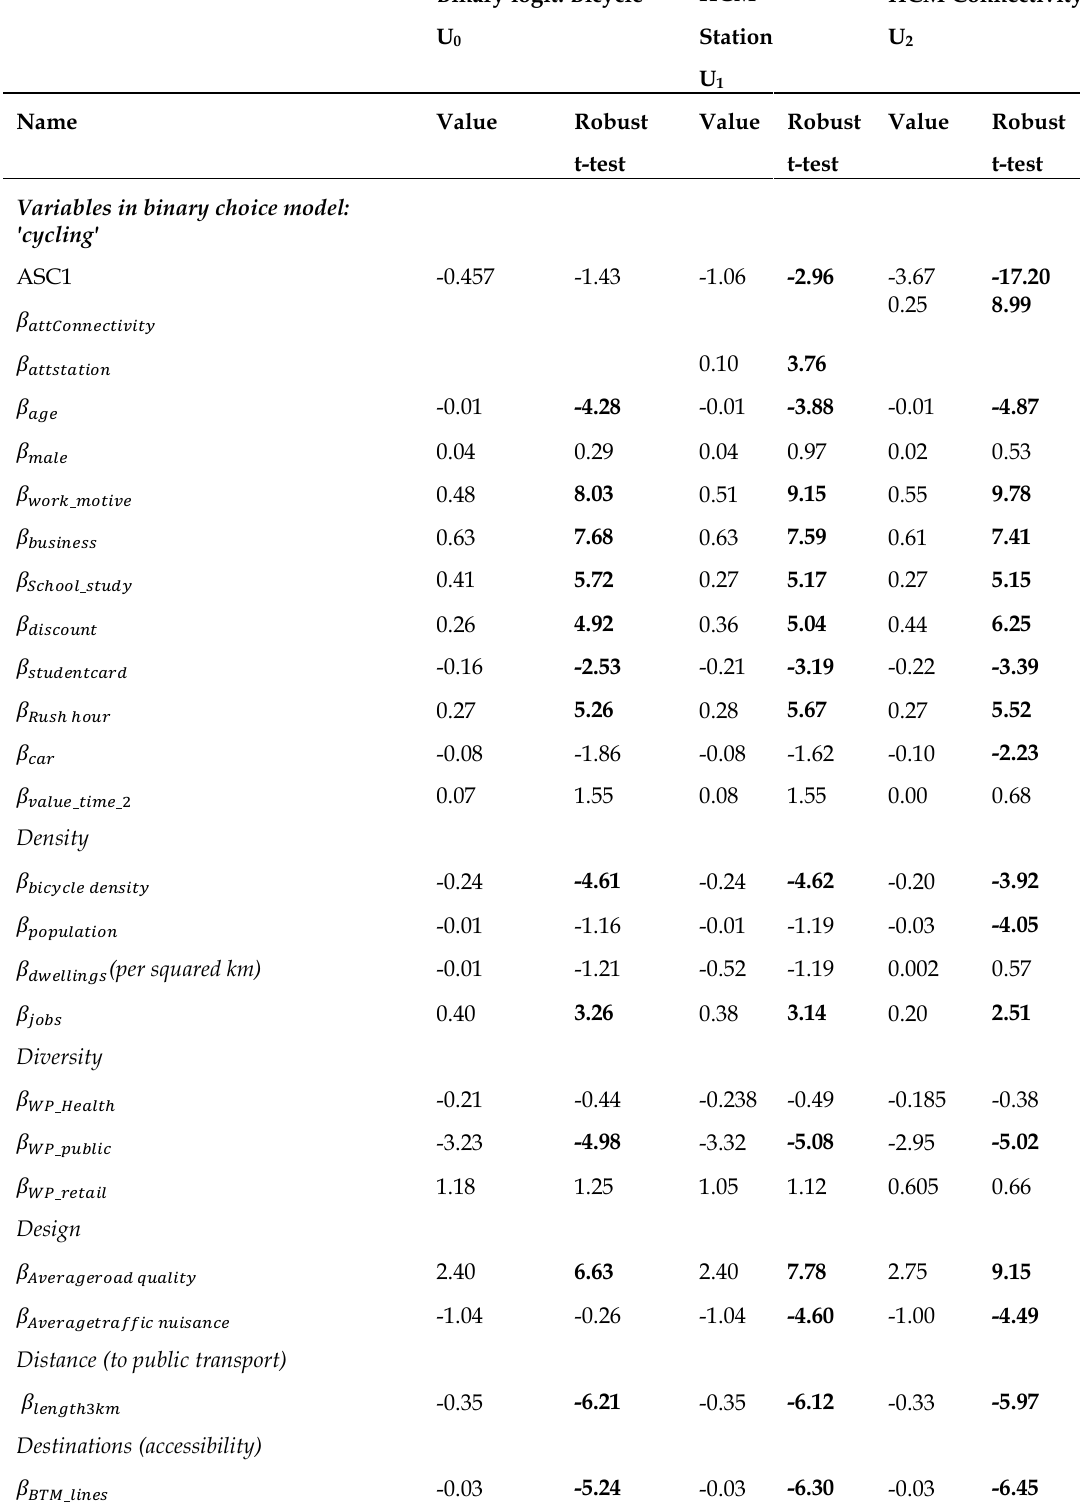
Table 1. Variables included in the utility functions Source: La Paix and Geurs (2015). Binary logit: